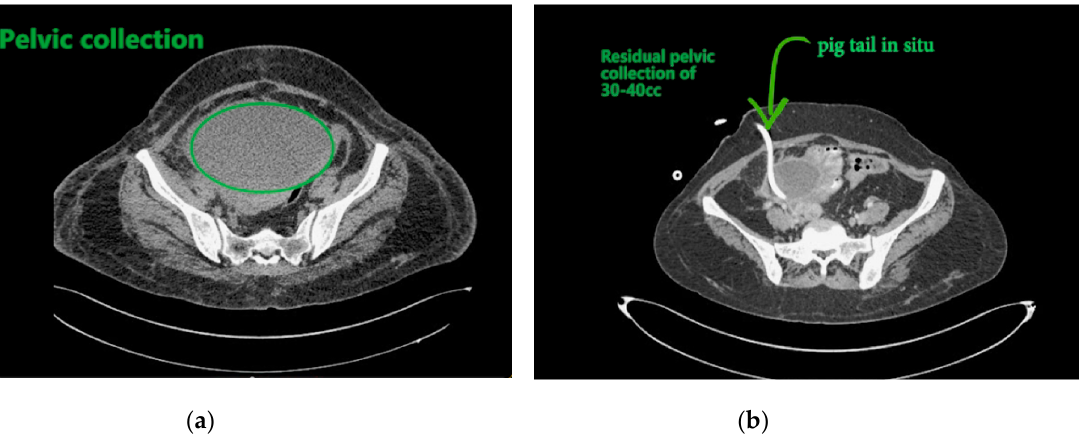
Figure 3. (a ) Pelvic collection; ( b ) showing residual collection in pelvis with drainage catheter in